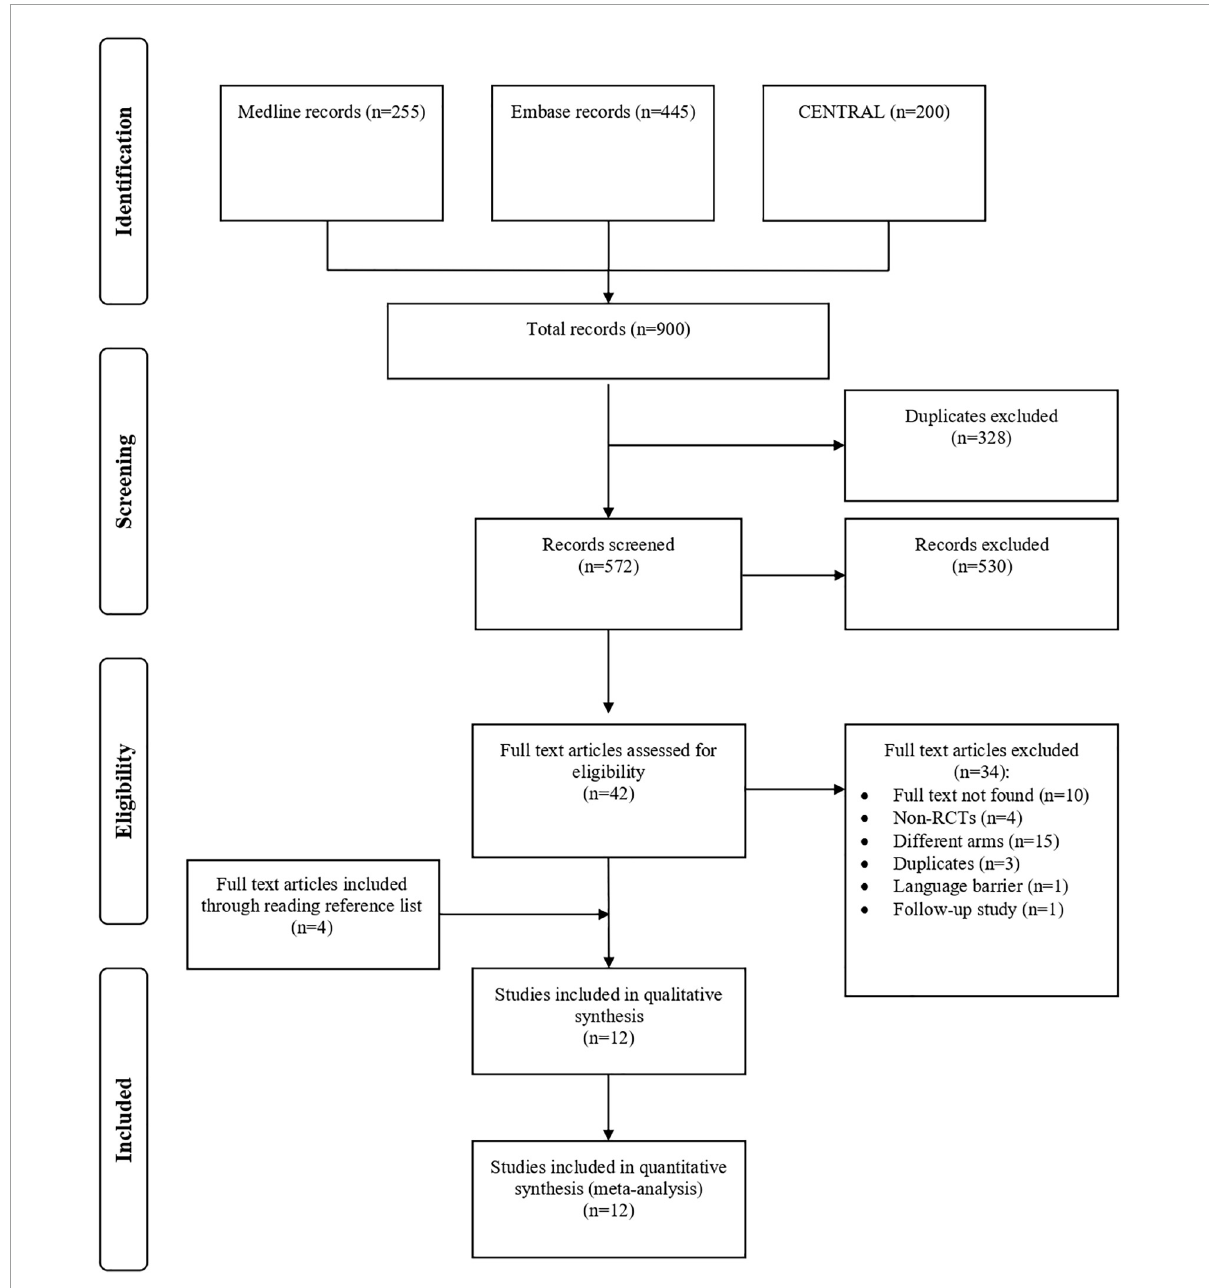
FIGURE1 Study flow